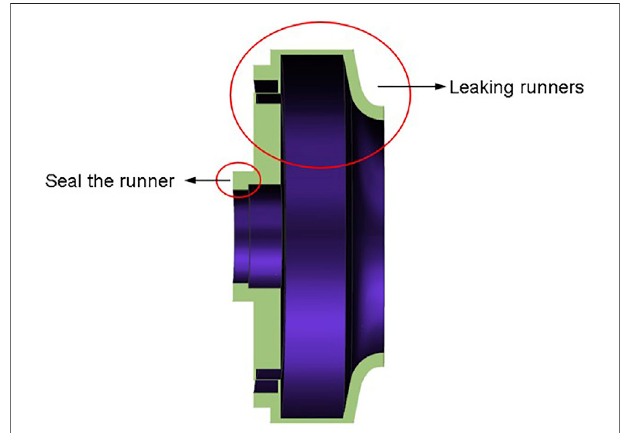
FIGURE 3 | Schematic diagram of the interior of the pump chamber.